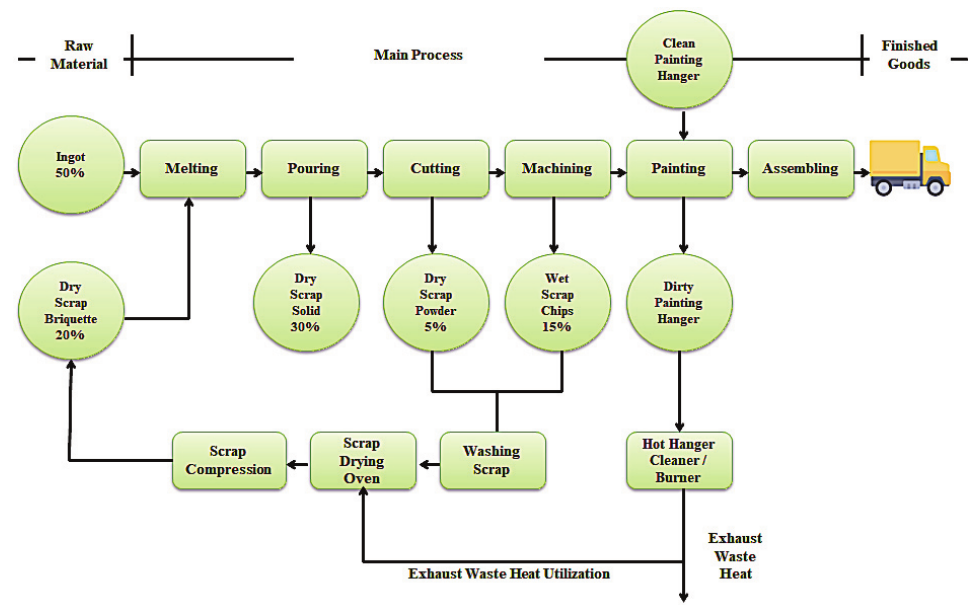
Fig. 1. Process flow of production and oven exhaust air utilization for aluminium scrap